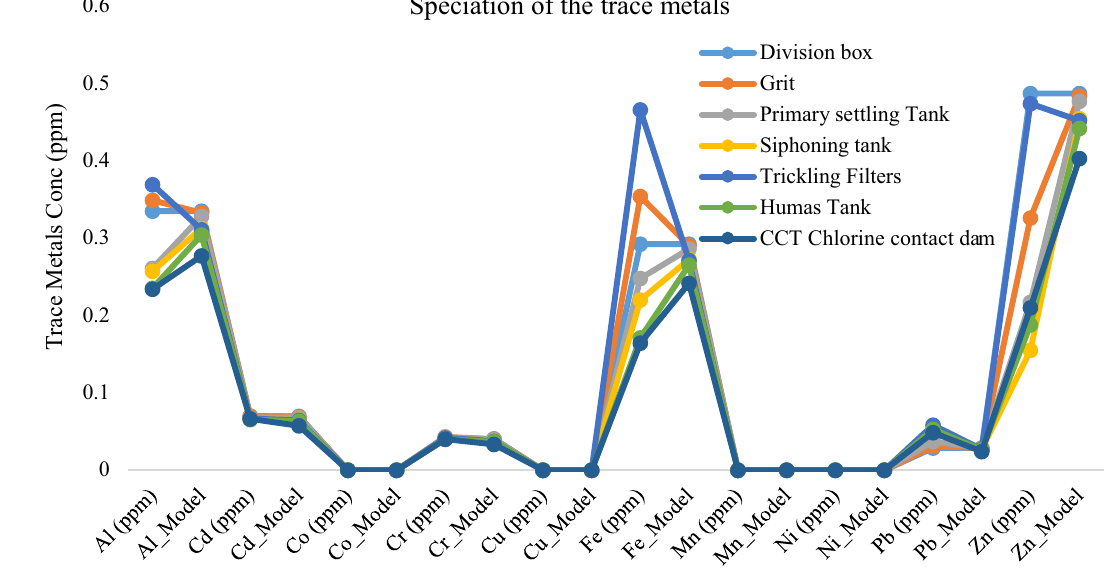
Fig. 3 Speciation of the trace metals in the biofilm